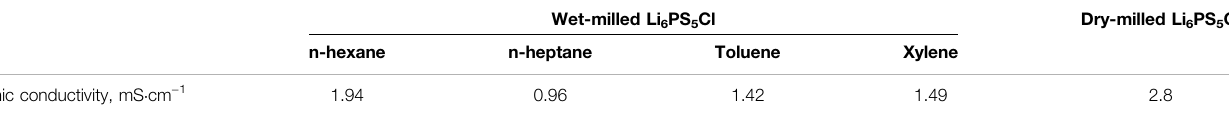
TABLE 1 | Ionic conductivities Li 6 PS 5 Cl electrolyte pellet samples.